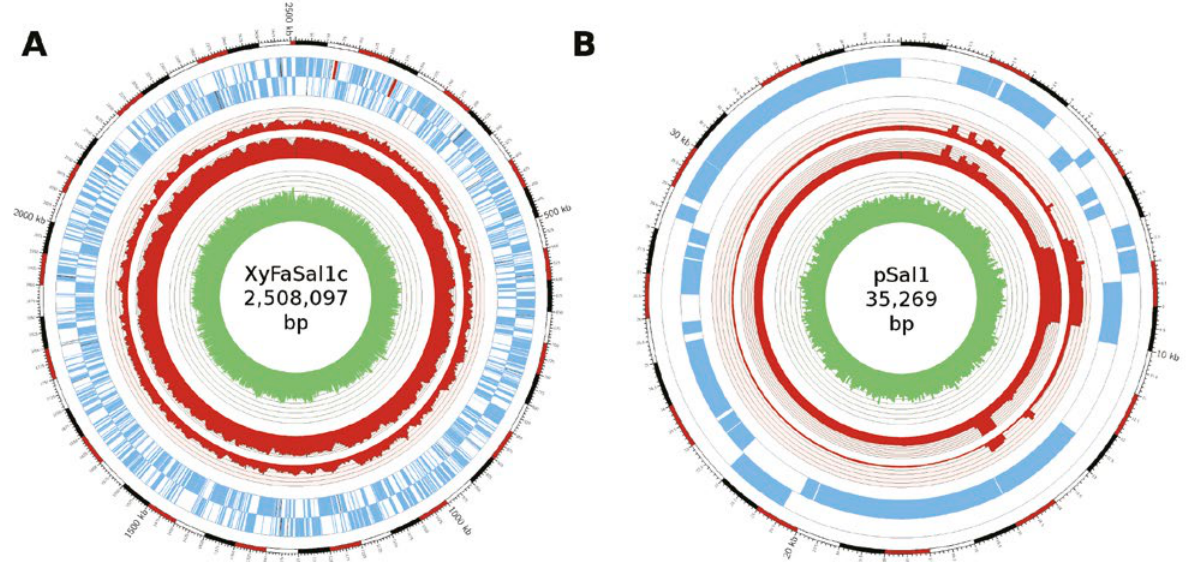
Figure 3. Circular representation of Xylella fastidiosa Salento-1 (NCPPB 4595; LMG 29352) complete genome (A) and plas - mid (B) obtained with Circos v. 0.69. Circle colours (from outside to inside) describe: 1) location of coding sequences in the two strands (light blue), tRNAs (black) and rRNA (red ) genes; 2) coverage in terms of consensus reads (range 0–50) (red); 3) coverage in terms of subreads (range 0–500) (red); and 4) the GC% (range 0–100%)